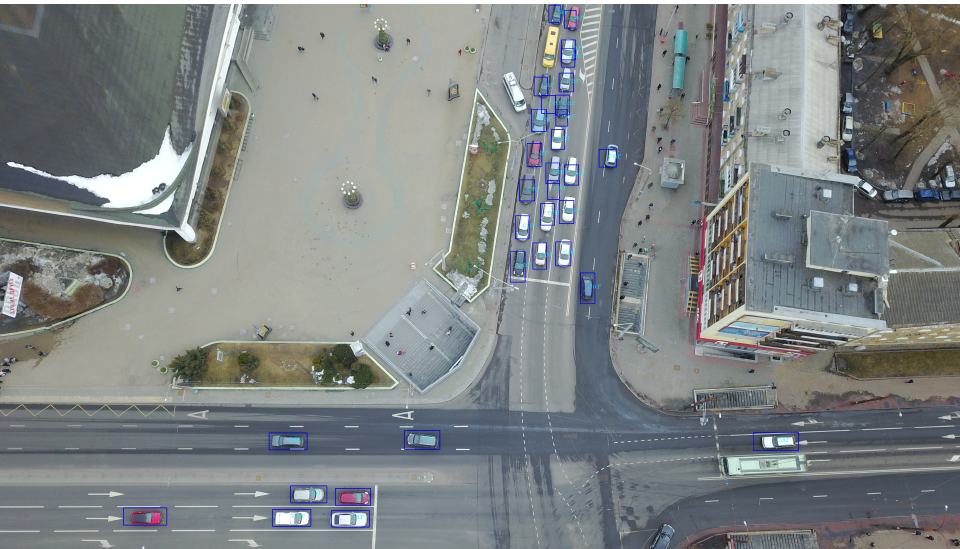
Figure 11. Example of YOLOv3’s output on an image of the PSU (Prince Sultan University) dataset, showing a few false negatives (non-detected cars).